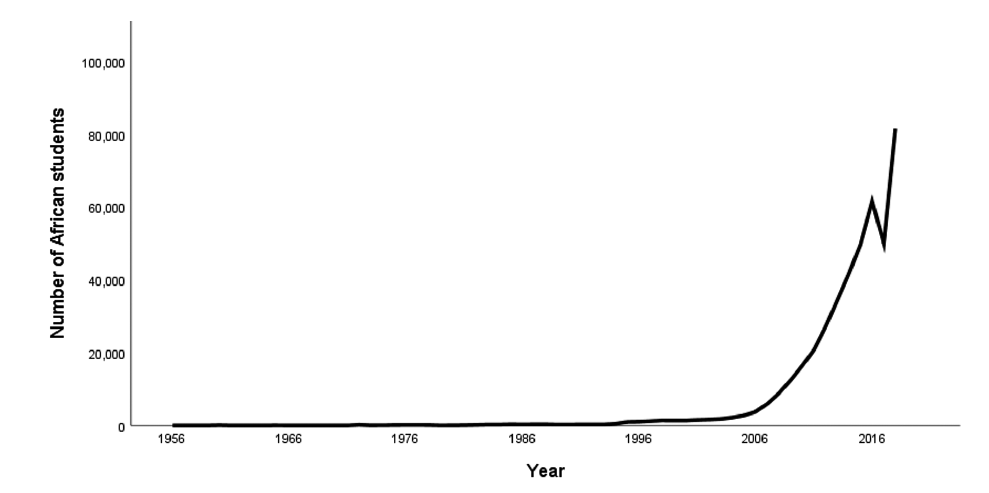
Figure 1. African students’ mobility to China